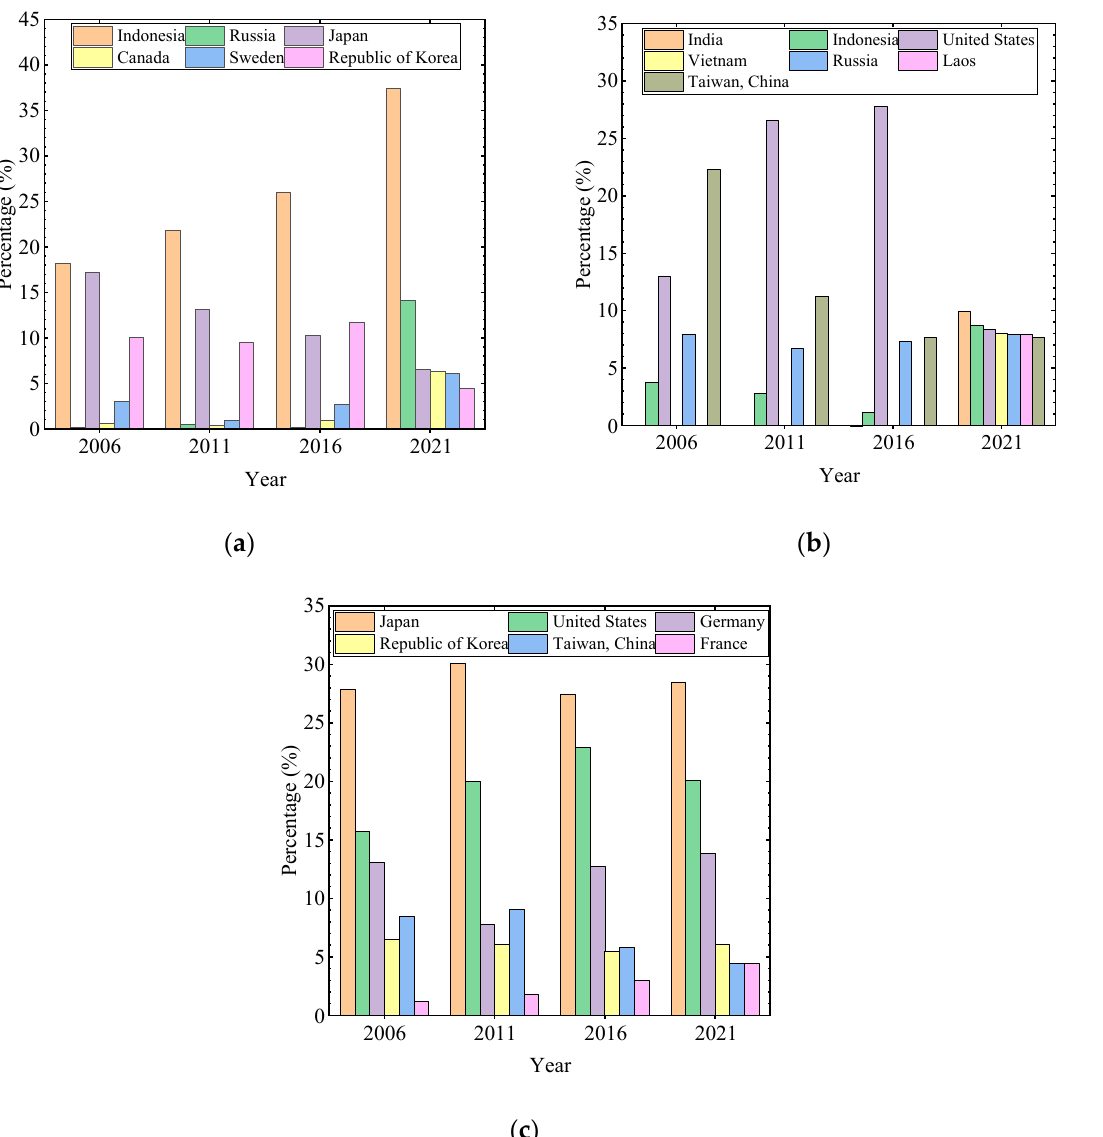
Figure 3. Percentage of major import trading partners for paper products in 2006–2021. ( a ) Newsprint and printing paper; ( b ) packaging paper products; ( c ) industrial paper products.